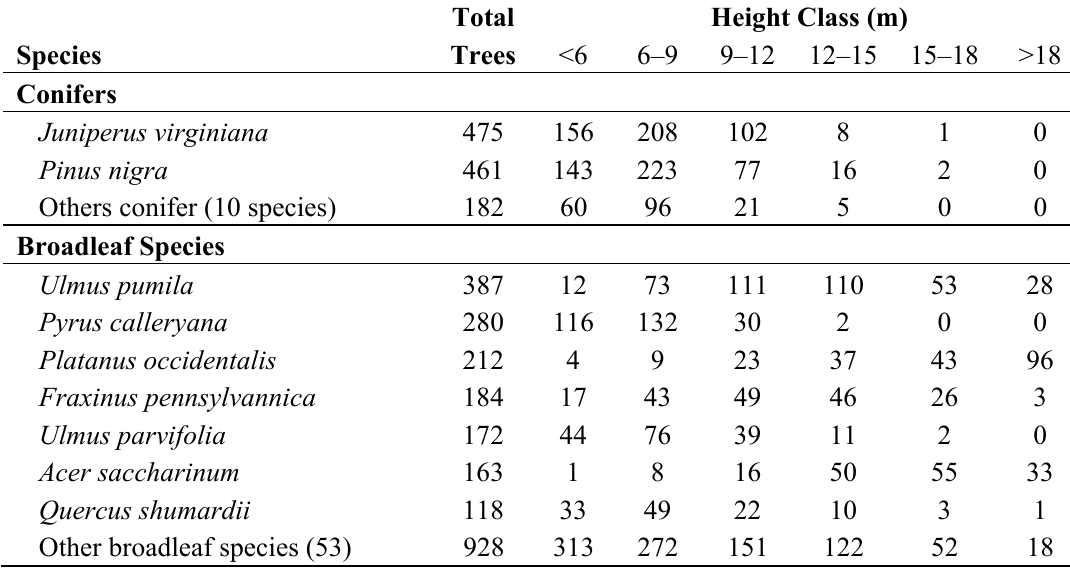
Table 5. Number of trees measured in the field by height class.